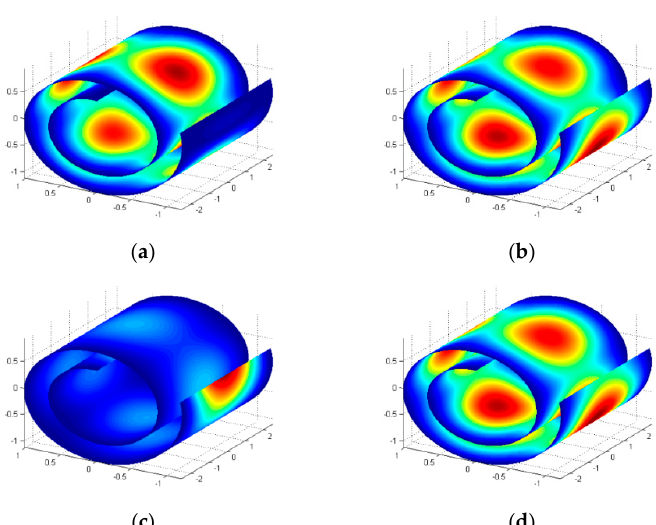
Figure 4 . First five mode shapes of the CNS with FCSS boundary condition.